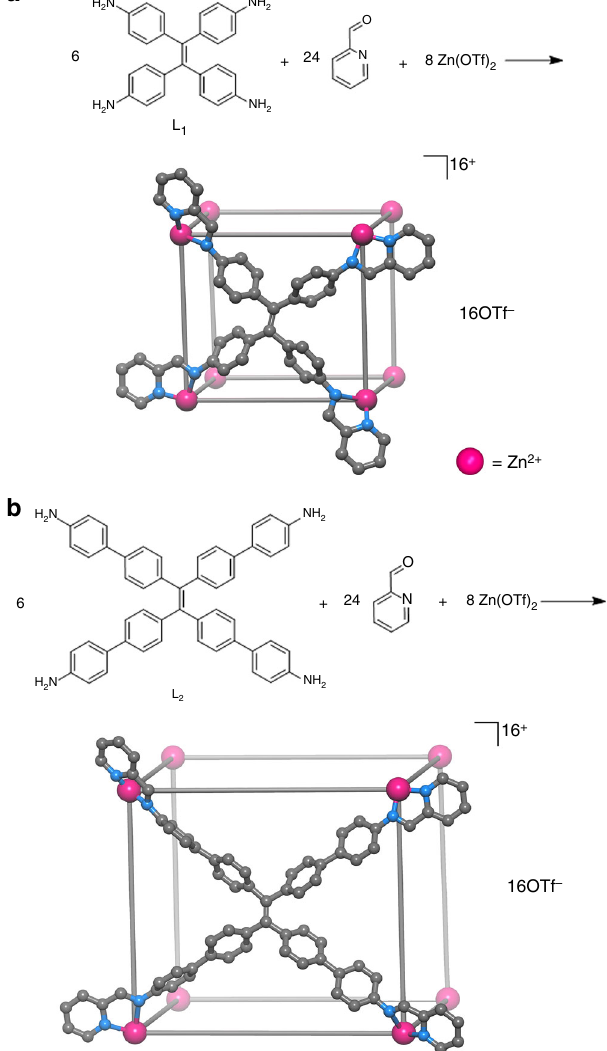
Fig. 1 Subcomponent self-assembly. a TPE- 1 and b TPE-